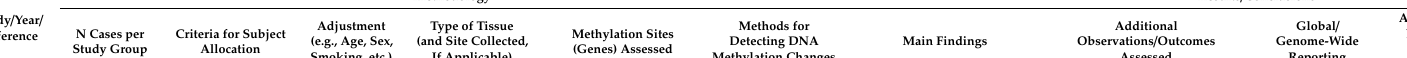
TIMP1 andPD,BOP andCAL:slight positivecorrelation between TIMP1 promotermethylation andPD,anda significantly negativecorrelation NR between TIMP1 promotermethylation andBOP. MMP9 andPD,CAL andBOP:No associationbetween methylationlevelsof MMP9 andPD,CAL